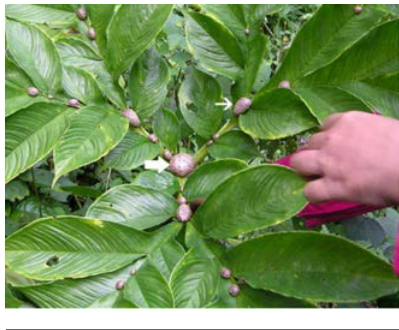
Figure 2. A) Pie cut of A. mueller i tuber; B). Mapping tuber parts considered as edge and center